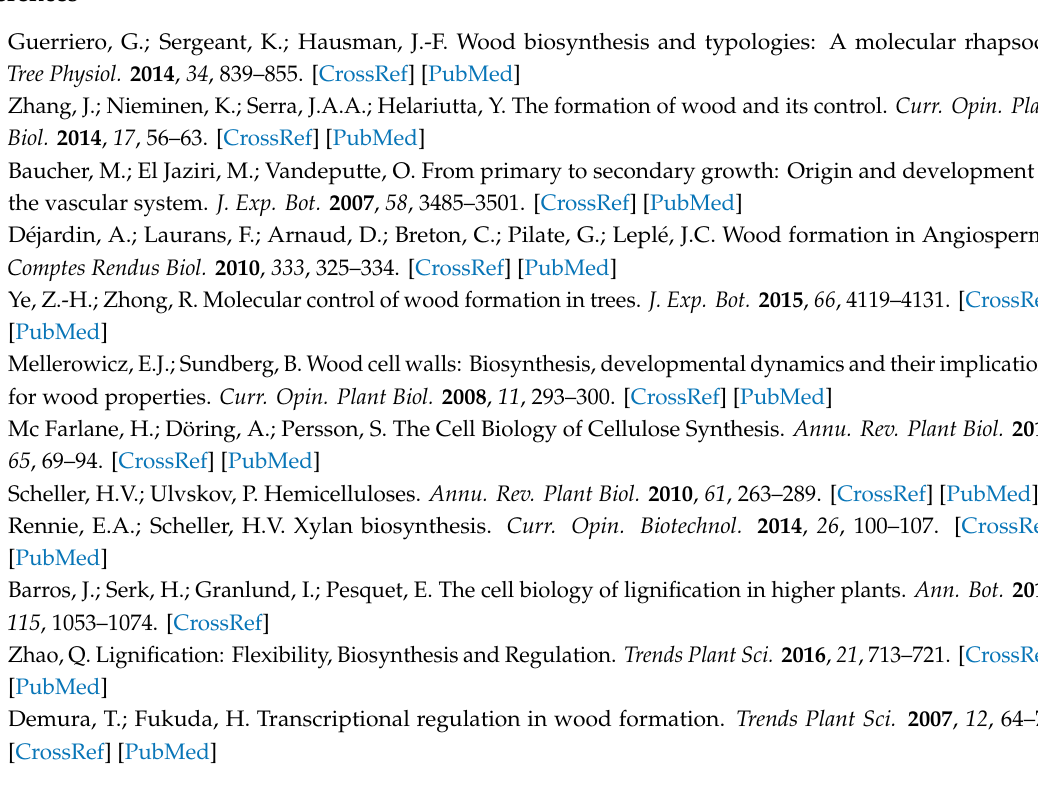
Figure S1: Motif sequences alignment of 288 RING-H2 genes identified in P. trichocarpa , Figure S2: Phylogenetic relationships, gene structure and motif of Populus RING-H2 genes, Table S1: The RING domain sequences of 540 P. trichocarpa RING genes, Table S2: List of 288 RING-H2 genes identified in P. trichocarpa and their protein lengths, Table S3: Probes of Populus RING-H2 genes, Table S4: List of primers used for qRT-PCR analysis, Table S5: Xylem development-related cis-elements analyzed in the 30 RING-H2 genes, Table S6: Analysis of xylem development-related cis-elements in the promoters of 20 RING-H2 genes that are not expressed in xylem. Author Contributions: Conceptualization, Y.C.; experiment design, X.M. and Y.C.; investigation, G.T., H.S., S.C. and W.X.; data curation, G.T., H.S., S.C. and W.X.; original draft preparation, G.T.; review and